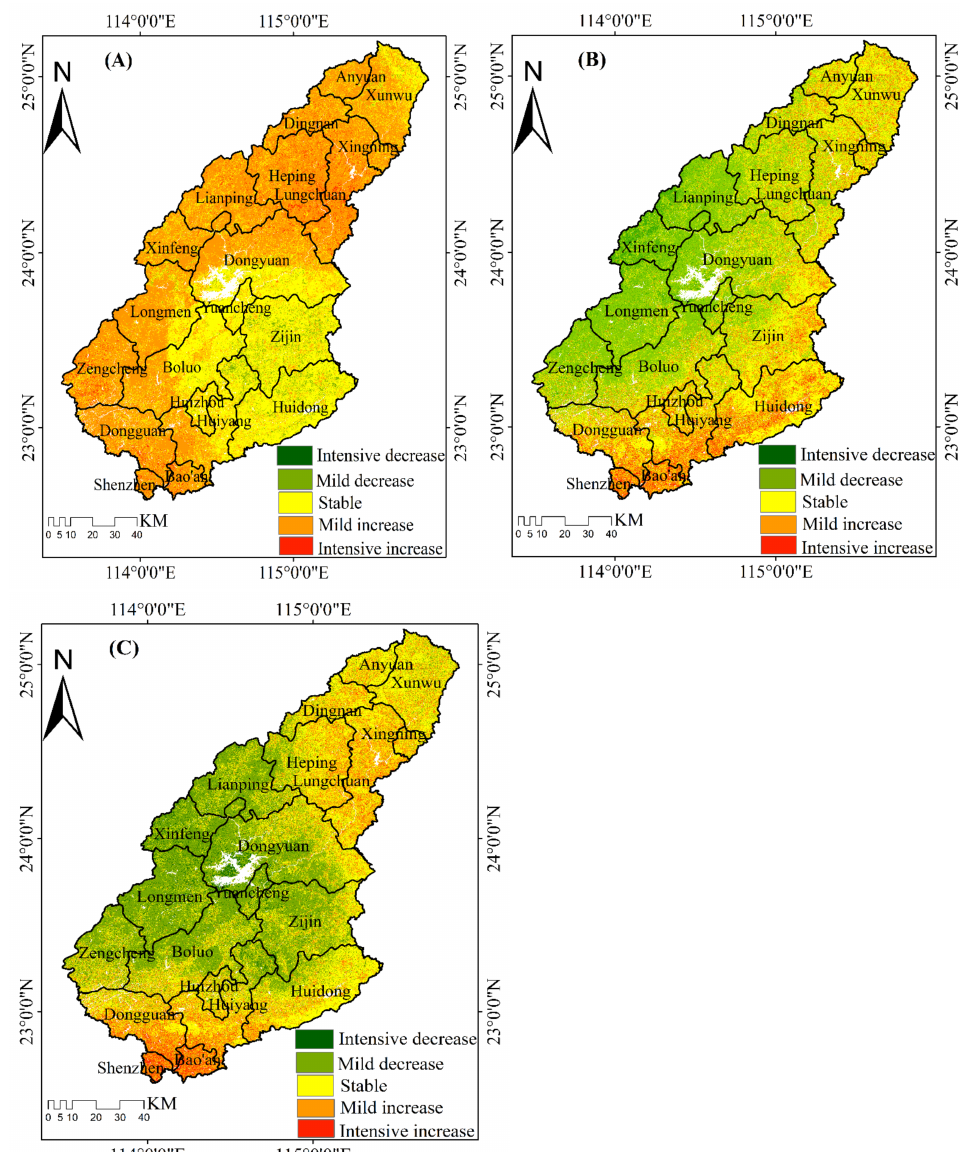
Figure 6. Dynamic changes in EV in DRB. ( A ) 2008–2001; ( B ) 2019–2008; ( C ) 2019–2001. From 2001 to 2008, the q-values in the 3–6 range were mainly vegetative cover, ele- vation, and precipitation. They exhibit a decreasing trend, indicating that the influence of these three factors on the EV was gradually weakening. This is mainly because the DRB is located in the humid region of southern China, with undulating terrain and dense vegetation; changes in the ecological environment are largely influenced by